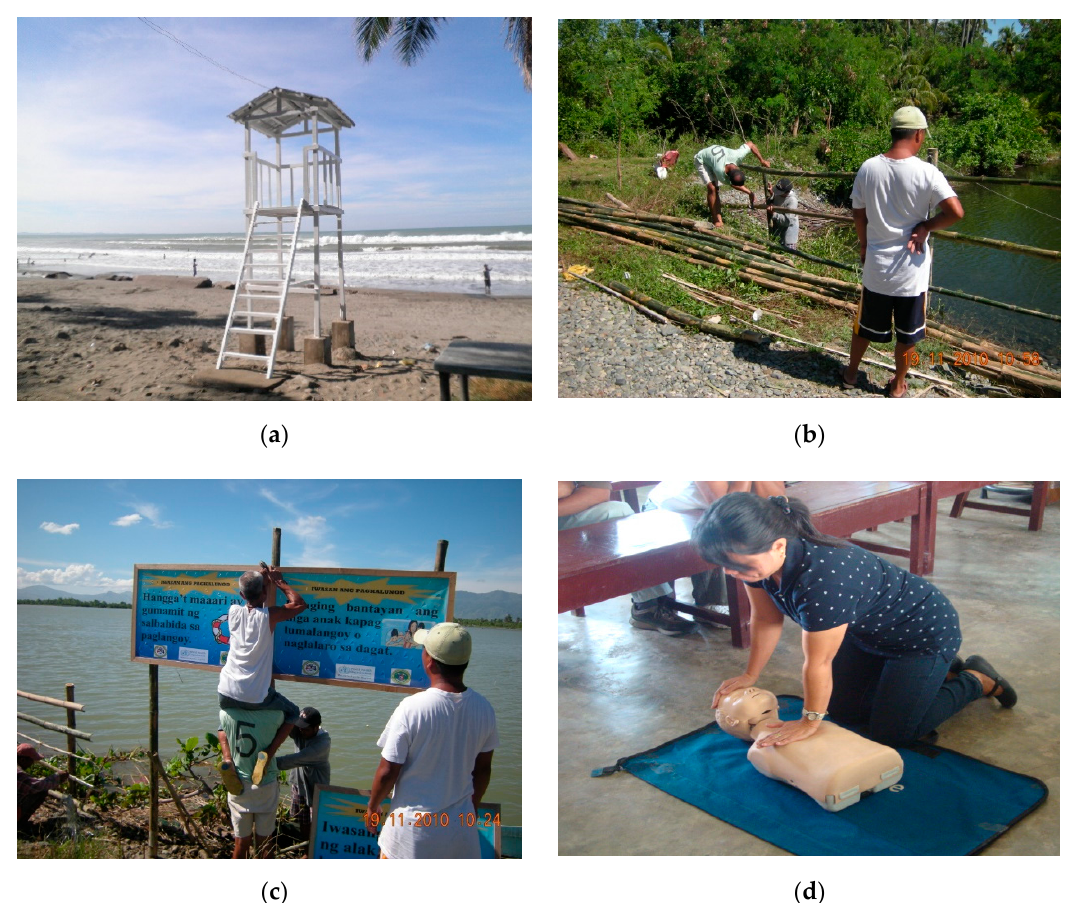
Figure 2. Community drowning prevention initiatives mentioned by key informants in the Philippines: ( a ) Guardhouses; ( b ) Barriers; ( c ) Signs; ( d ) Cardiopulmonary resuscitation (CPR) training.